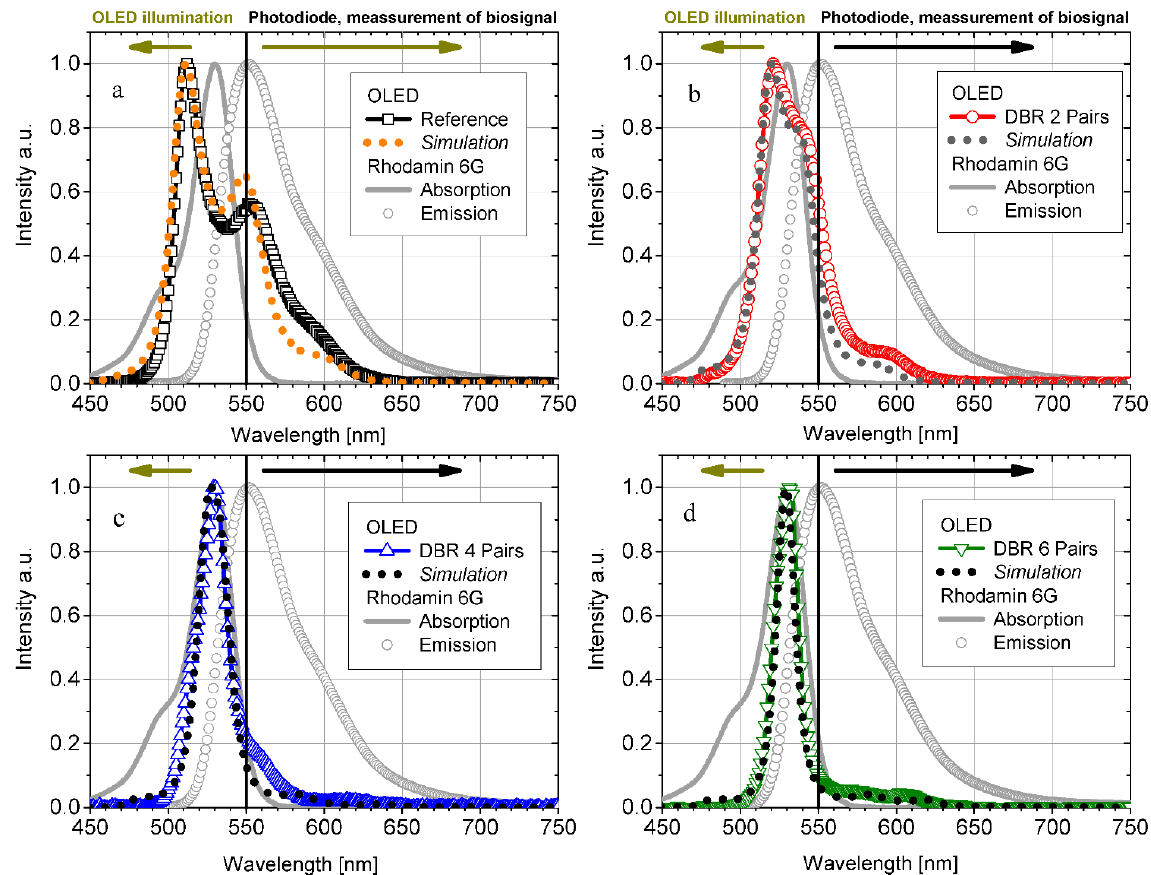
Figure 3. All graphs express the normalized spectral radiance as intensity. The graphs in ( a ) exhibit the spectral emission of the reference OLED in comparison to the OLED devices with including DBR mirror; ( b ) two DBR Pairs; ( c ) four DBR pairs; ( d ) six DBR pairs. The grey solid line presents the excitation spectra and the open dotted line the emission spectra of R6G in a water solution excited and recorded with a Fluoromax-4 from Horiba Jobin